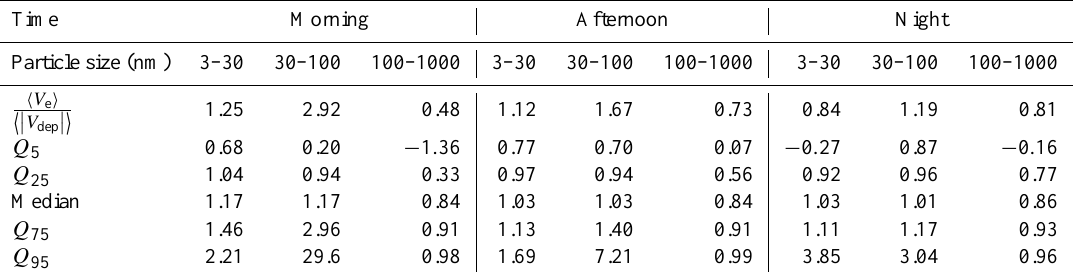
Table 2. Statistics of the ratio of the flux at the canopy top to deposition sink integrated over the canopy over a 10-day period in May 2013. For more details see Table 1. Morning refers to the time period from sunrise until noon, afternoon from noon until sunset and night from sunset until